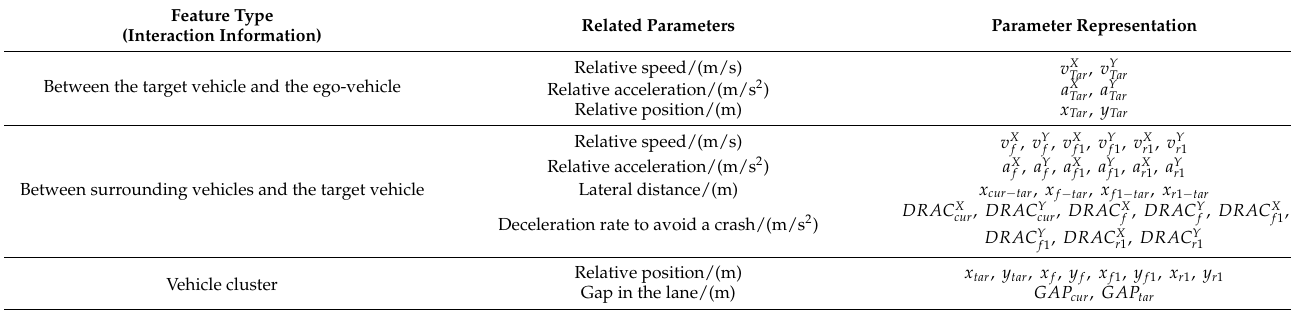
Table 1. Interactive feature